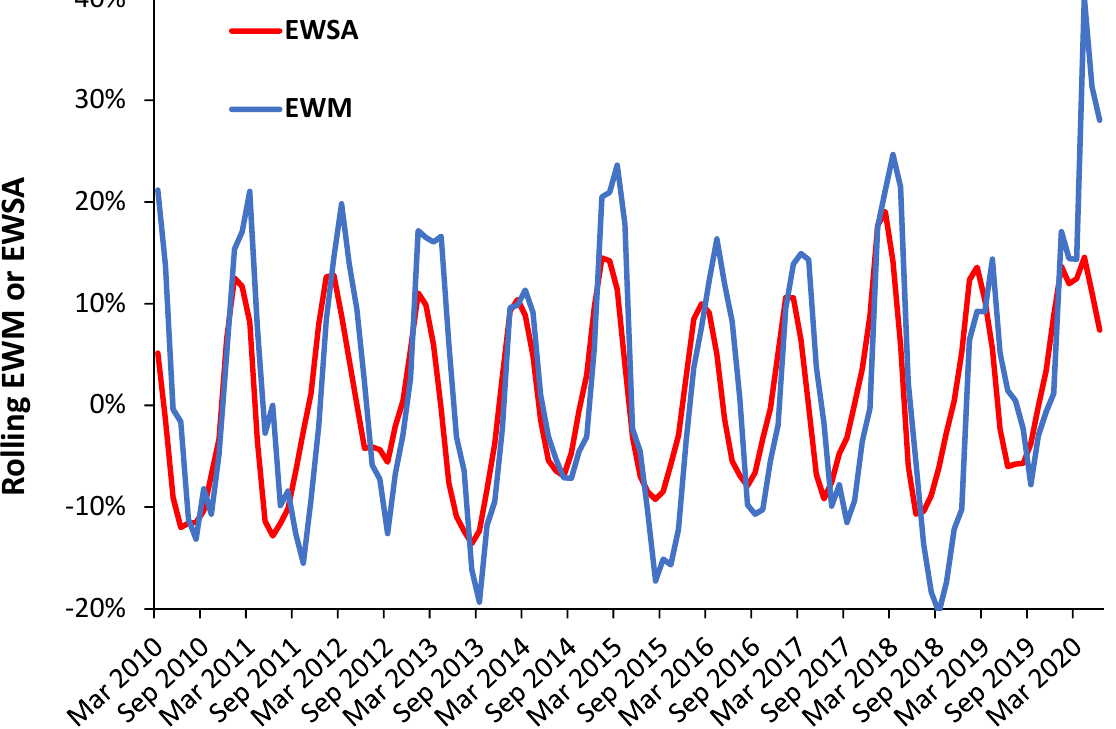
Figure 10. Rolling EWM and EWSA calculation in the Midlands of England. EWSA uses NHS staff sickness absence.